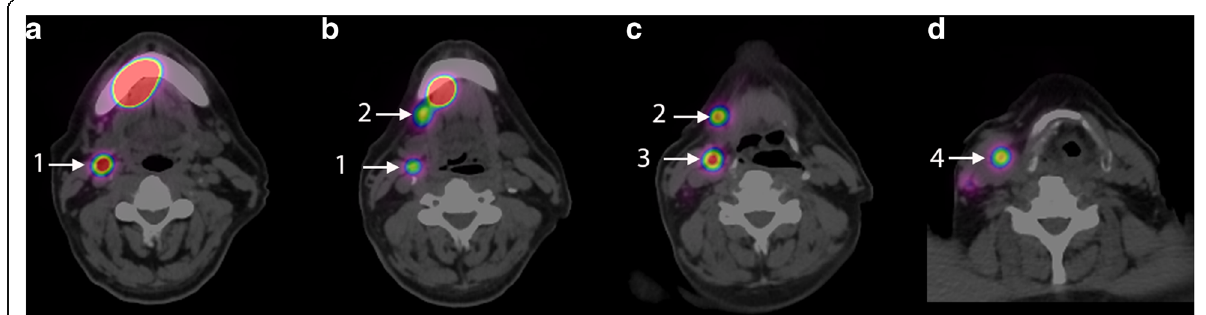
Fig. 2 a – d Axial fused PET/CT images of patient 5 showing the injection site of 89 Zr-nanocolloidal albumin in the floor of mouth on the right side and clear uptake in SLNs in levels IB (2), level II (1 and 3) and level III (4) on the right side. The distance between the injection site and the uptake in the SLN in level IB was 18